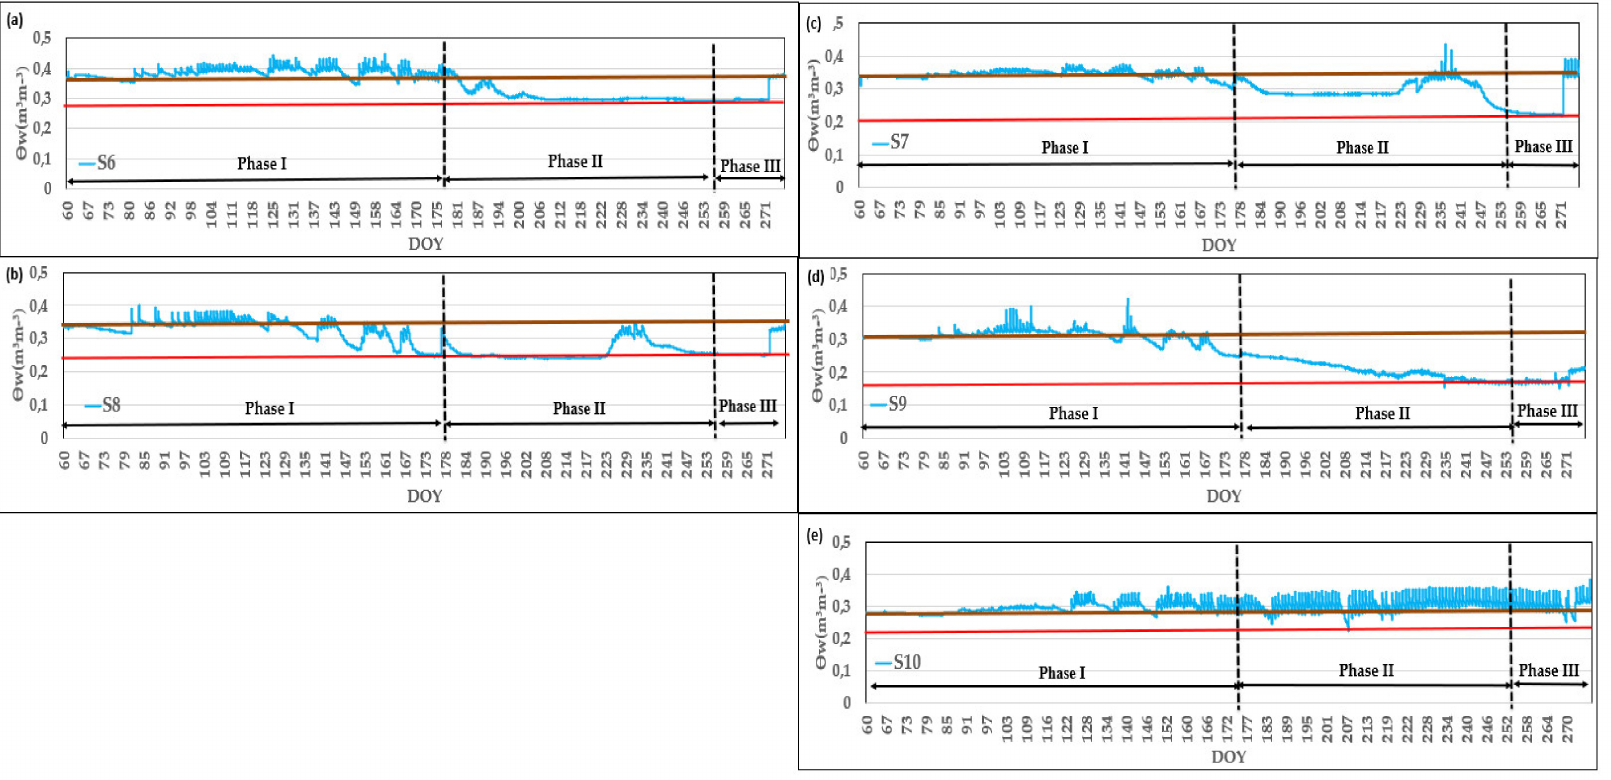
Figure 6. Temporal trends of soil moisture measured by moisture sensors located in di ff erent positions: ( a ) A at 0.3 m depth, ( b ) A at 0.3 m depth, ( c ) A at 0.6 m depth, ( d ) A at 0.6 m depth and ( e ) B at 0.3 m depth. Θ w is the moisture content. All the probes were installed at CR2 for the automatic irrigation system. The brown line corresponds to the high reference value of the sensor and the red line to the low reference value. The period represented corresponds to the irrigation campaign in the year 2017. DOY is the day of the